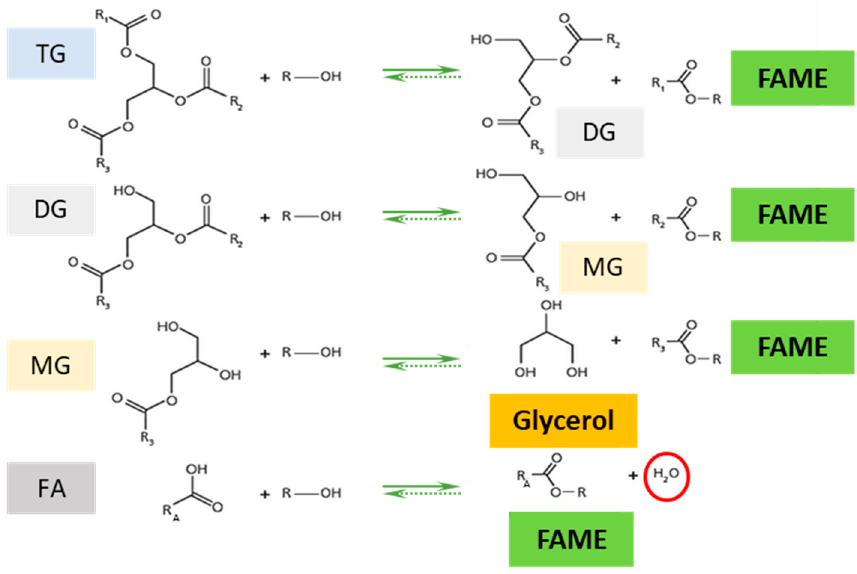
Figure 1. Simplified schemes of the transesterification of a triglyceride and of direct esterification of a free fatty acid with methanol to synthesize biodiesel. TG: Triglyceride; DG: Diglyceride; MG: Monoglyceride; FAME: Fatty acid methyl ester.